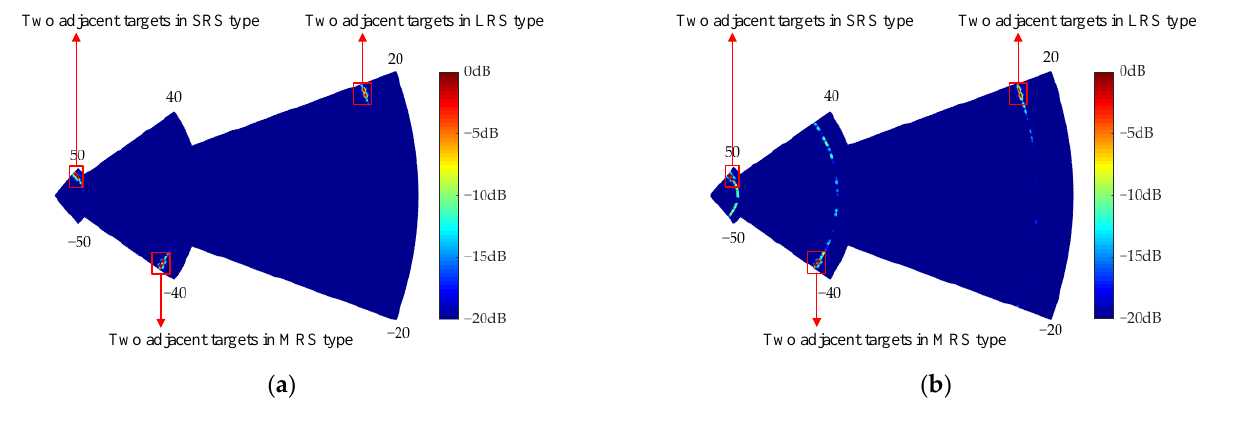
Figure 11. The estimation results of the range – azimuth spectrum: ( a ) The MAM-MIMO sparse array for CARs; ( b ) the uniform half-wavelength array. Table 5. Multi-target parameters setting.